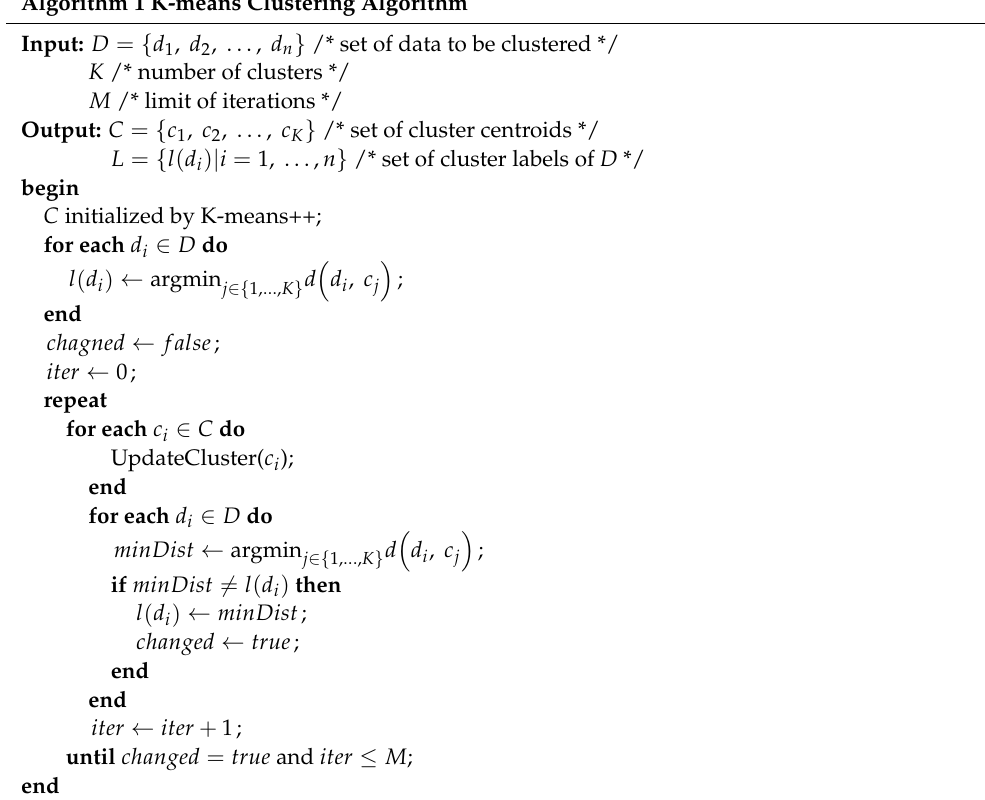
Algorithm 1 K-means Clustering